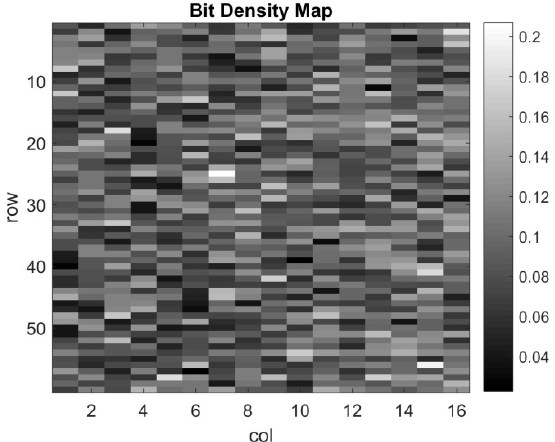
Figure 12. Measured D-log-H for all clusters, demonstrating good uniformity of threshold from 0.3 to 0.8 e-.